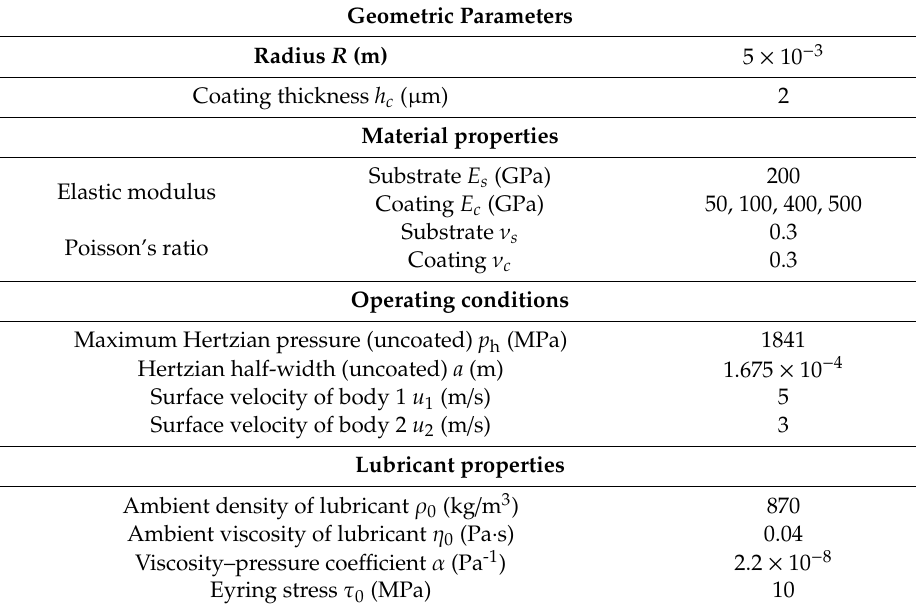
Table 1. The main parameters used for the coated EHL